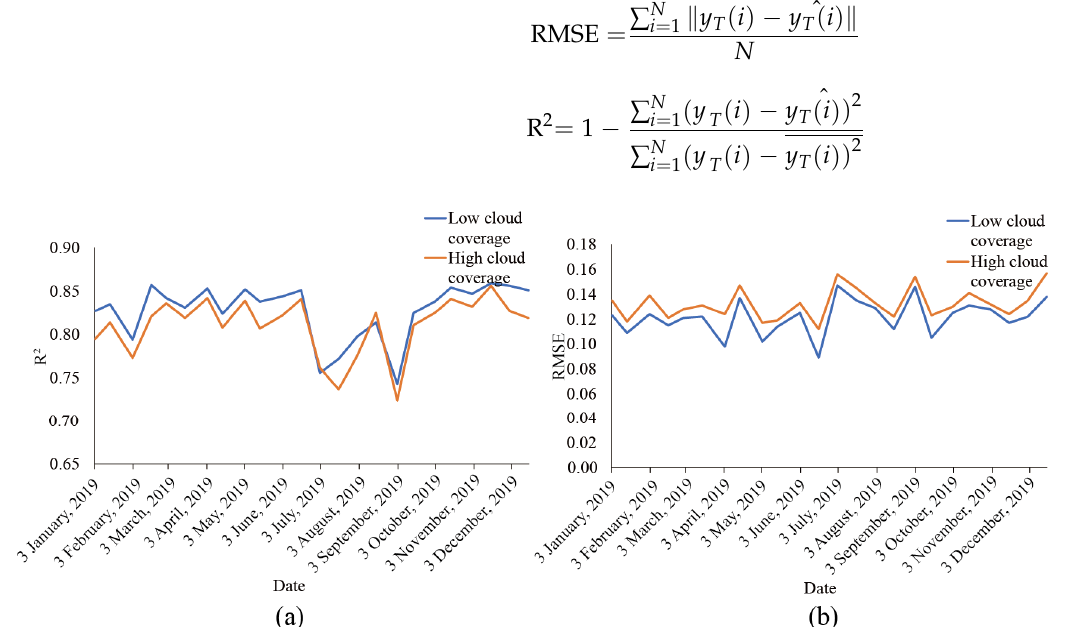
Figure 8. Accuracy curves of NDVI retrieval results in 2019. ( a , b ) represent the evaluation curves of R 2 and RMSE, respectively. The blue line indicates the accuracy under low cloud coverage conditions; the orange line reflects the performance of the double-attention RNN on thick clouded images.